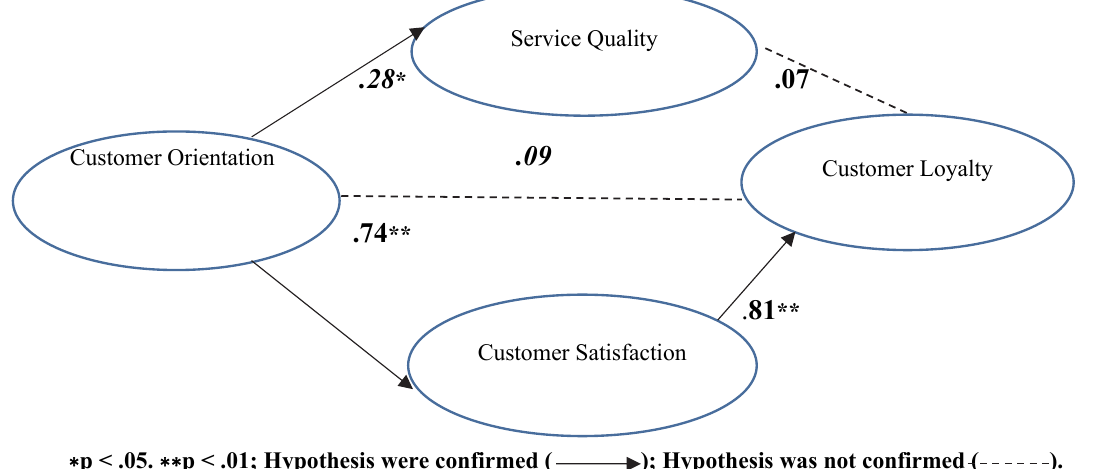
Fig. 2. Customer Orientation-Customer Loyalty Model via Service Quality and Customer